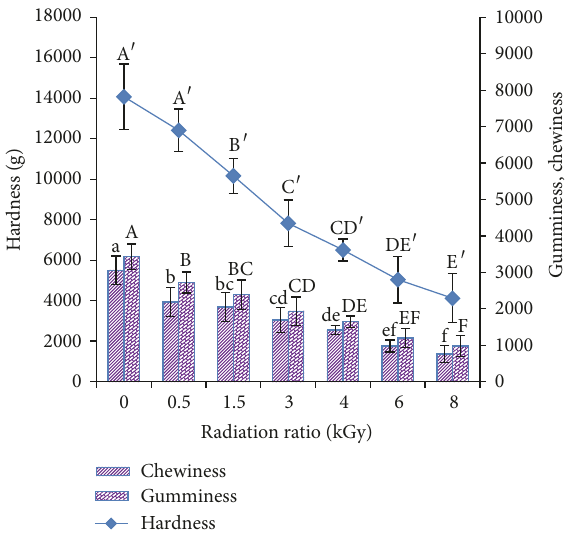
Figure 3: Effect of irradiation on texture profile properties of SBJ. Values are represented as mean ± SD. Significance was tested by Duncan Multiple Range Test at 𝑃 < 0.05 , and values with the same superscript were found not significantly different from each other.